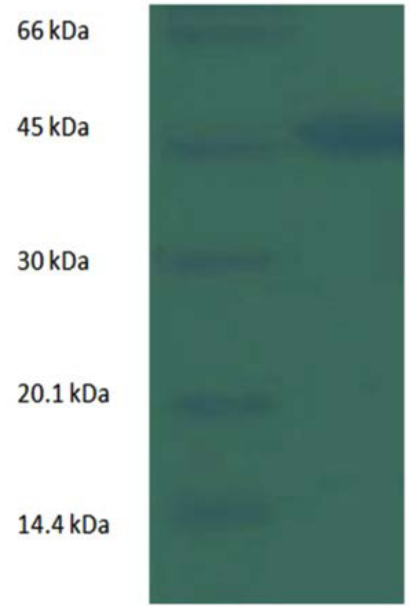
Fig. 1. SDS_PAGE of Cellulase enzyme extracted from